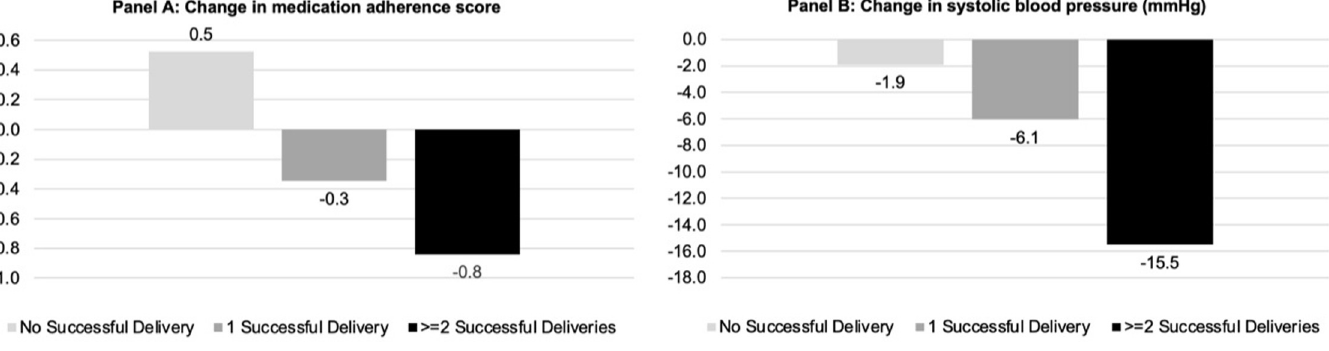
Fig 2. Change in self-reported medication adherence score and systolic blood pressure measurement.